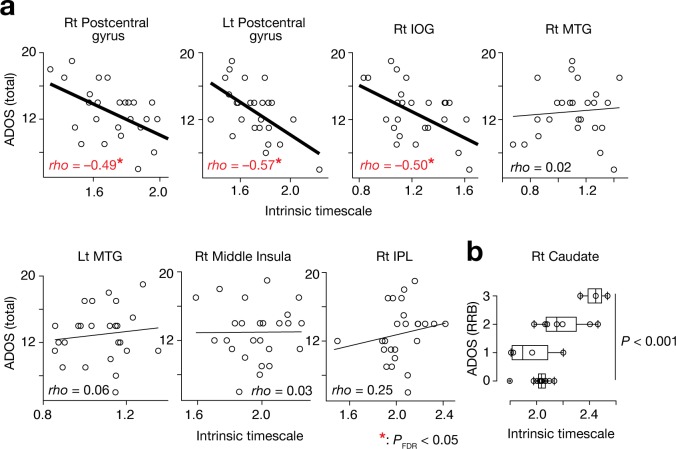
Associations between the intrinsic neural timescale and ASD symptoms.(a) We found negative associations between the intrinsic timescale and the overall severity of ASD in the bilateral postcentral gyri and right IOG but not in the bilateral middle temporal gyri (MTGs), right middle insula, and right inferior parietal lobule (IPL). The intrinsic timescales of the regions represent the averages of the timescale values within the clusters. The statistical threshold for the seven brain-behaviour comparisons was corrected by FDR. (b) The intrinsic neural timescale in the right caudate was not correlated with the overall severity of autism, but was associated with that of repetitive, restricted behaviours (RRB) of ASD.